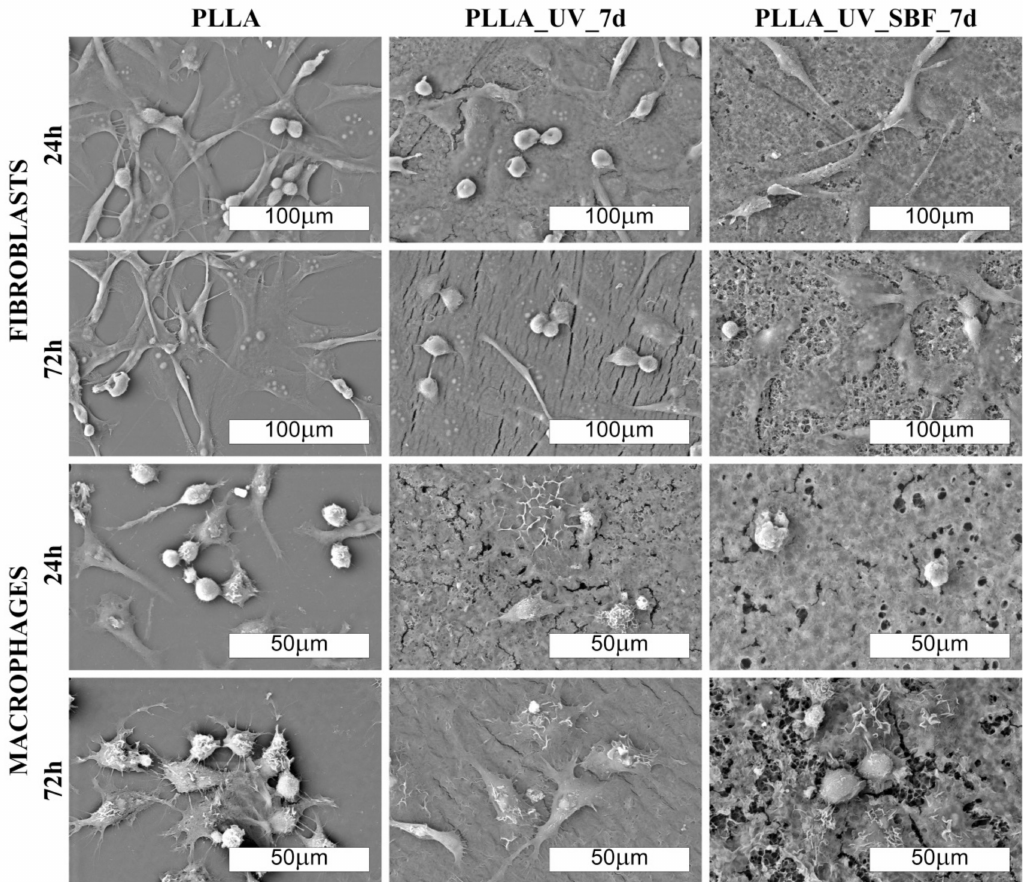
Figure 7. SEM images of fibroblast and macrophage colonies (500 × and 1000 × magn., respectively) on the laser-modified samples after one day of incubation in air (PLLA_UV_7d) and in SBF (PLLA_UV_SBF_7d) compared to the unmodified PLLA